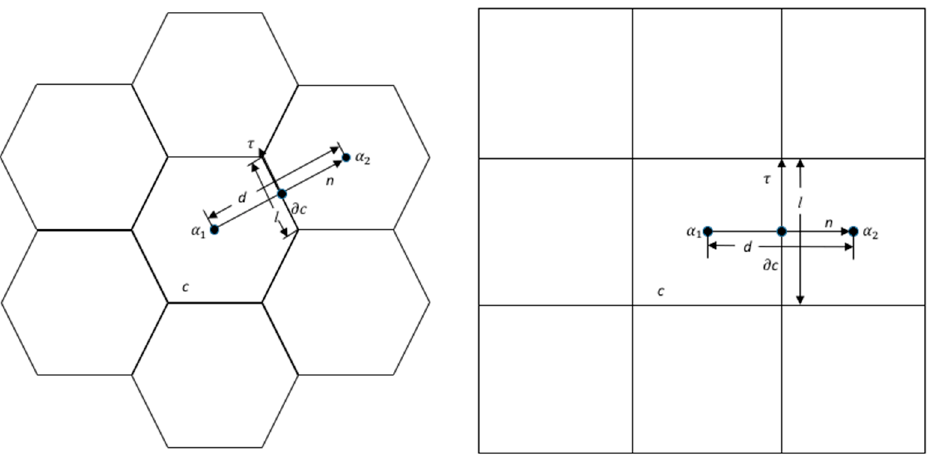
Figure 1. Voronoi Z-grid finite volume scheme for different grid cells.